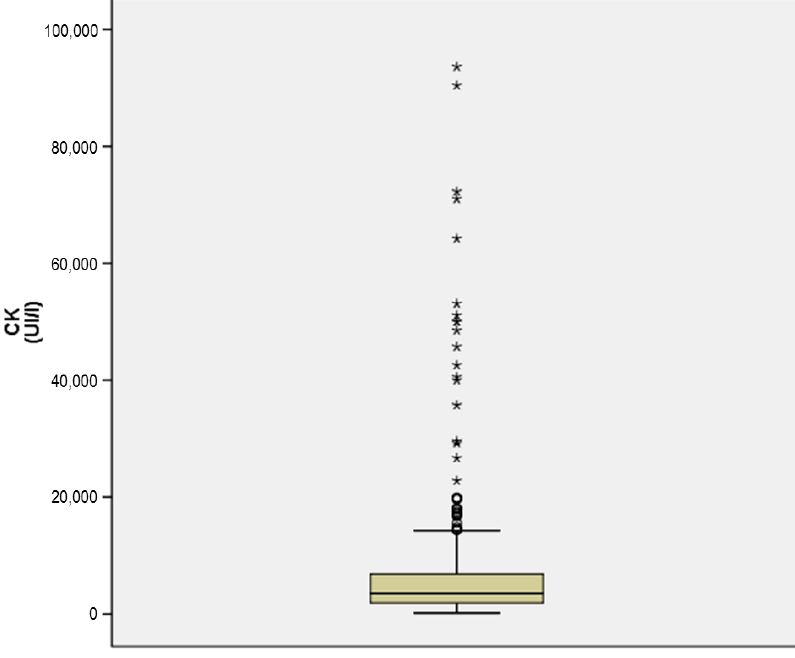
Figure 2. Graphic representation of the CK activity (UI/L) of bulls after physical exercise.